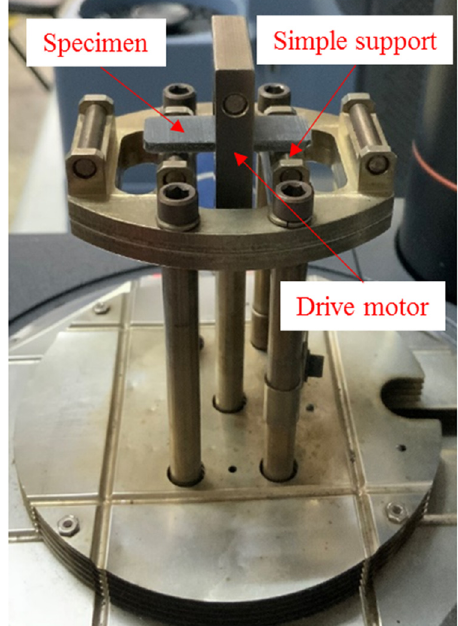
Figure 3: DMA setup picture.